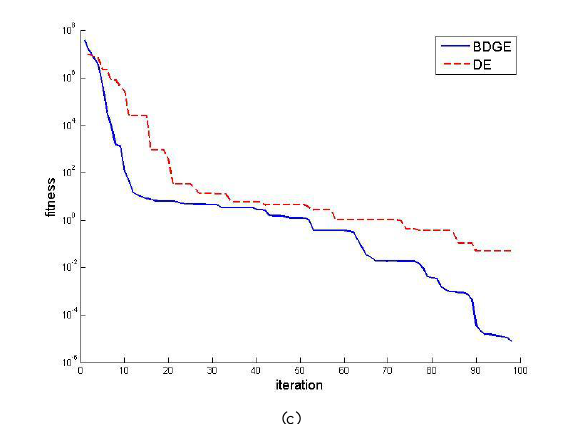
Fig. 5 Comparison of BDGE and DE in Testing of (a)f1, (b)f4,